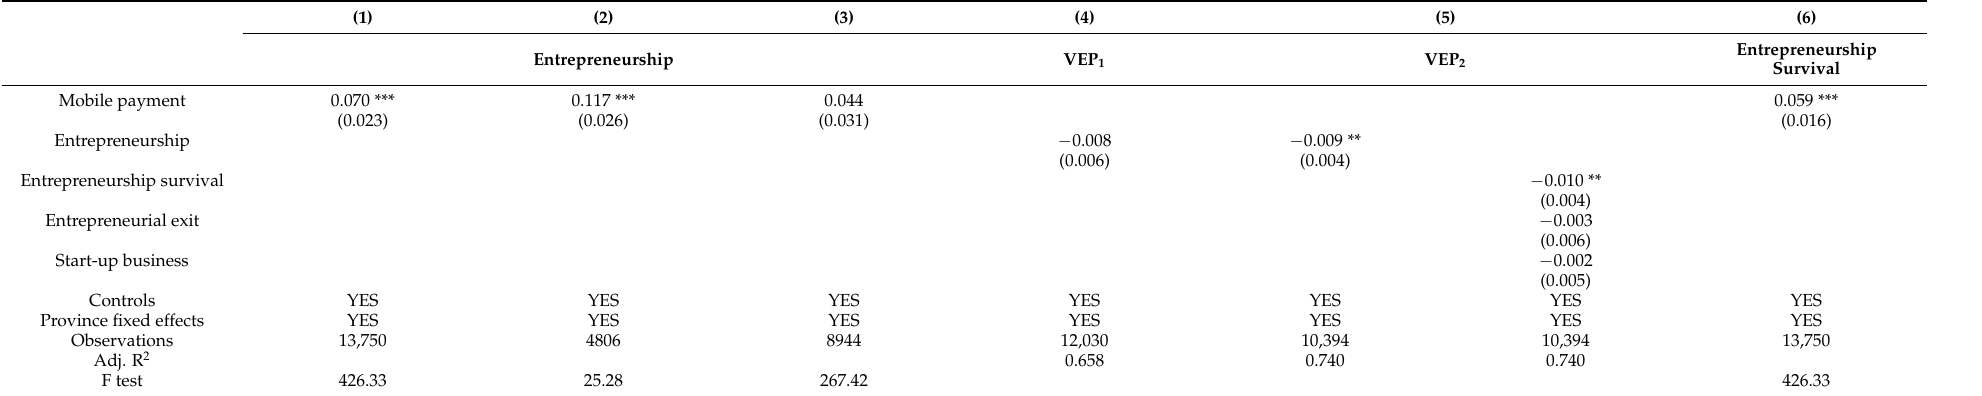
Table 6. The results of the entrepreneurship mechanism test.